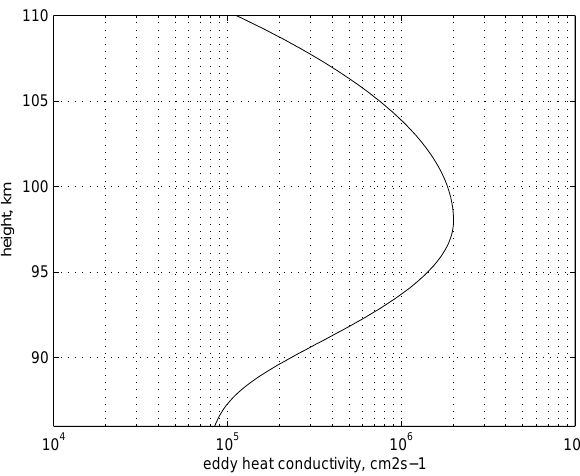
Fig. 5. The eddy heat conductivity coefficient profile used to calcu- late the heating rate profile shown in Fig. 4. This is based on eddy diffusivity and taking P =